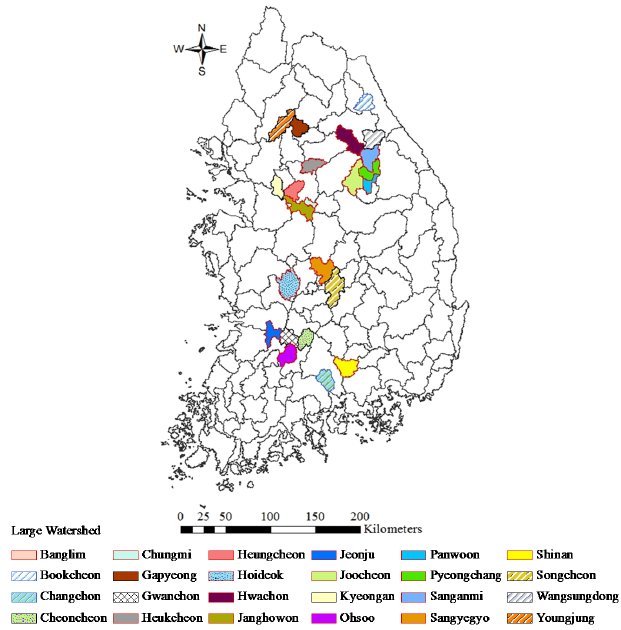
Figure 1. Location of large watersheds (Area > 250 km 2 ) in the study area. Small watersheds (Area ≤ 250 km 2 ) can be seen in [14].